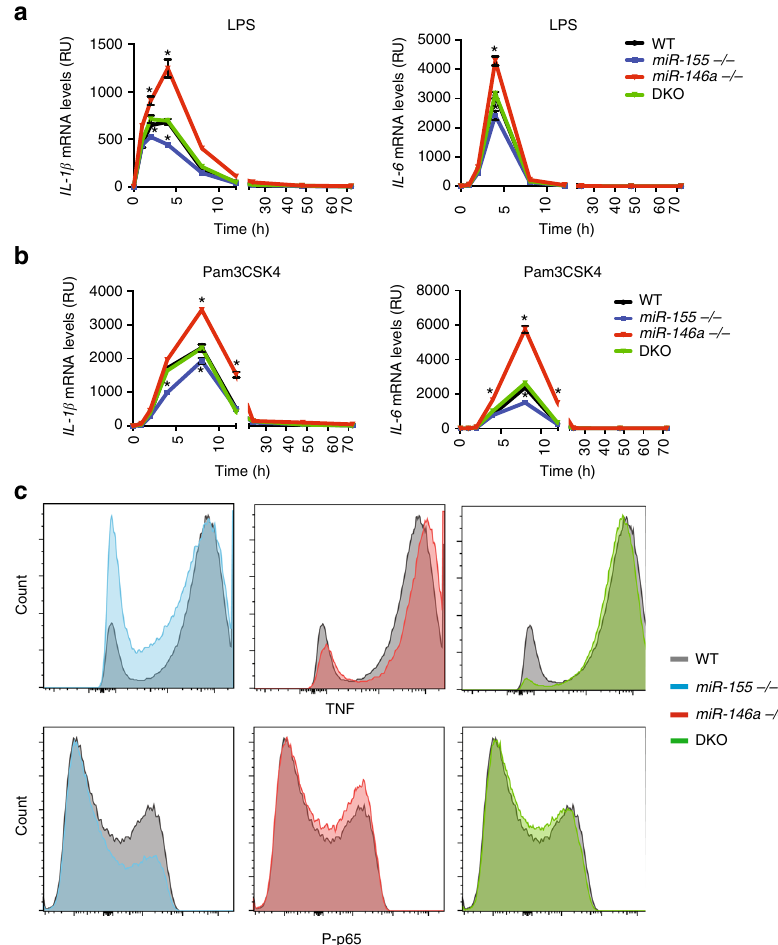
Fig. 6 Mir-155 acts as an ampli fi er in suboptimal stimulation. WT, miR-155 − / − , miR-146a − / − and double knock out (DKO) BMMs were stimulated with low levels of LPS (10 ng/mL) ( a ) or Pam3CSK4 (5 ng/mL) ( b ). mRNA levels of IL-1 β (left) and IL-6 (right) were then quanti fi ed using qRT-PCR. c TNF and phospho-p65 (P-p65) protein expression of BMMs from WT (grey), miR-155 − / − (blue), miR-146a − / − (red) and dKO (green) 4 h after stimulation with low levels of LPS (10 ng/mL) as measured by FACS using intracellular staining. N = 4 per group from at least two independent experiments, represented as mean ± SEM. a , b * p < 0.05, using two-way